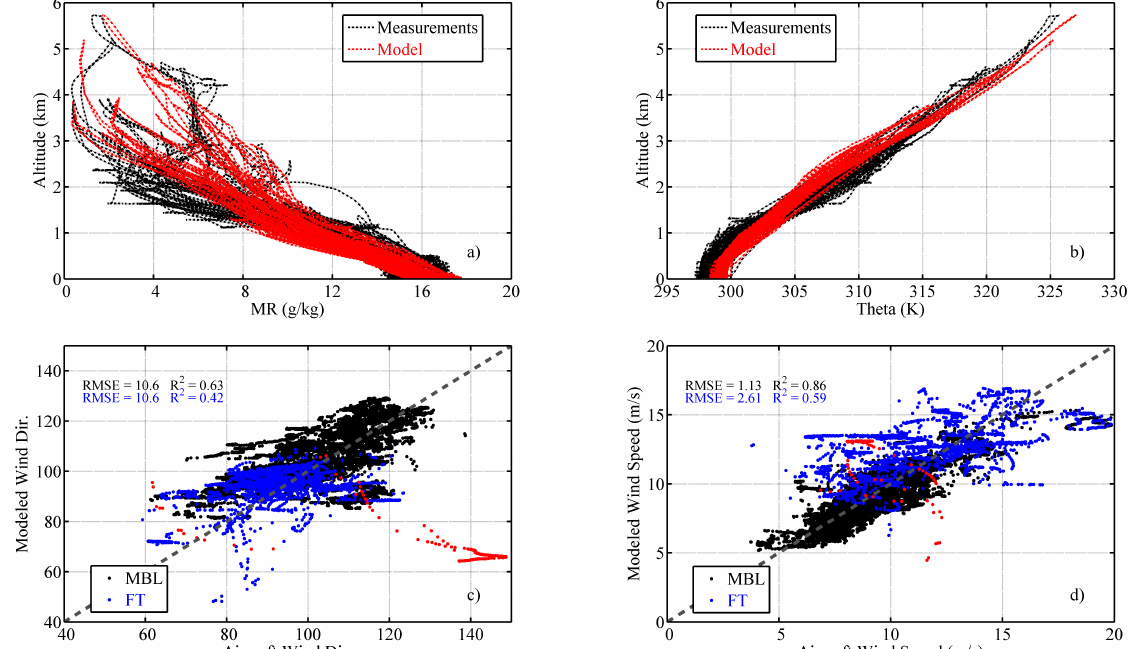
Fig. 3: Modeled data vs. in-situ measurements along FT flight tracks for (a) MR, (b) θ , (c) wind direction and (d) wind velocity for all research flights. The grey dashed lines in c) and d) mark the 1:1 relationship. Anomalous FT data from research flight 12 are highlighted in red in the lower row. See section 3 for discussion.